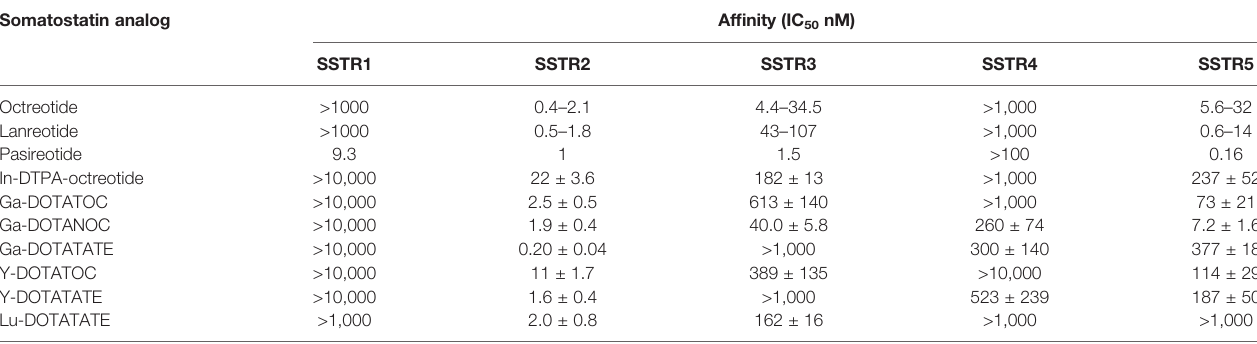
TABLE 1 | Somatostatin Analog Af fi